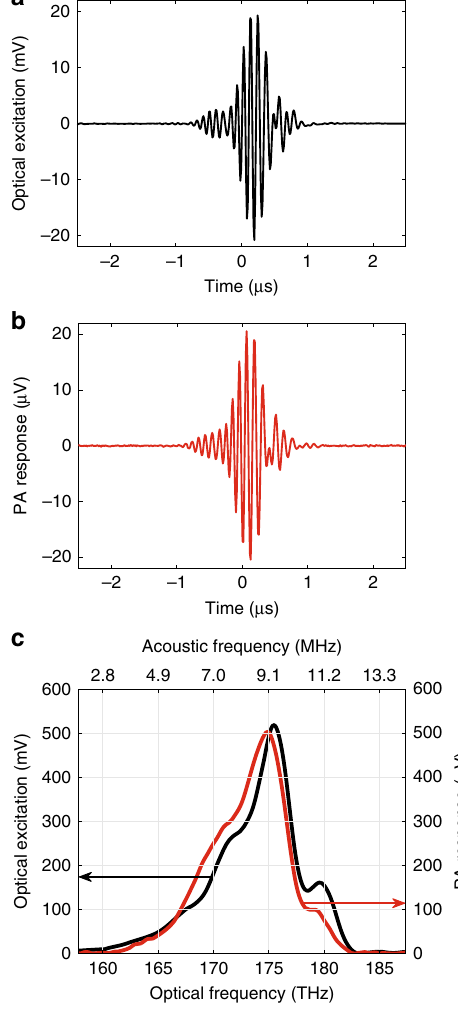
Fig. 3 Dual-comb photoacoustic spectroscopy of a vertically aligned carbon nanotube fi lm embedded in polydimethylsiloxane. a Time-domain interferogram for the optical excitation measured by the ac-coupled photoreceiver. b Time-domain interferogram for the PA response at the transducer output (obtained by dividing the measured signal by the ampli fi er gain). These time-domain signals are obtained with 60 seconds of real-time coherent averaging. c Optical excitation spectrum (black line, left axis) and spectrally resolved PA response (red line, right axis). The spectrally resolved data are obtained by fi rst apodizing the time-domain signal with a 4.8- μ s window (zero-padded outside of window), then Fourier transformation, and fi nally scaling to optical frequencies (see equation (2)). The upper axis in c shows the beat frequencies or acoustic frequencies before scaling to optical frequencies. In b an acoustic propagation time, t acoustic = 14 μ s, was subtracted to account for the propagation time of the acoustic waves in water between the sample and transducer. The average optical power incident on the sample is ≈ 24